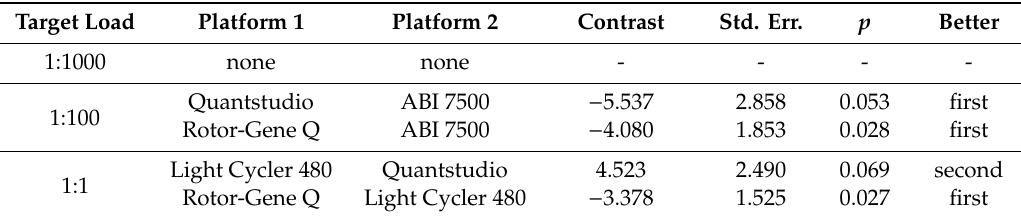
Table 3. E ff ect of the thermocycler platform on the Cq values of three panel specimens (1:1, 1:100, and 1:1000 dilutions) tested multicentrically (20 assays across 16 international laboratories) [15]. Only significant ( p < 0.05) and quasi-significant (0.05 < p < 0.1) results are